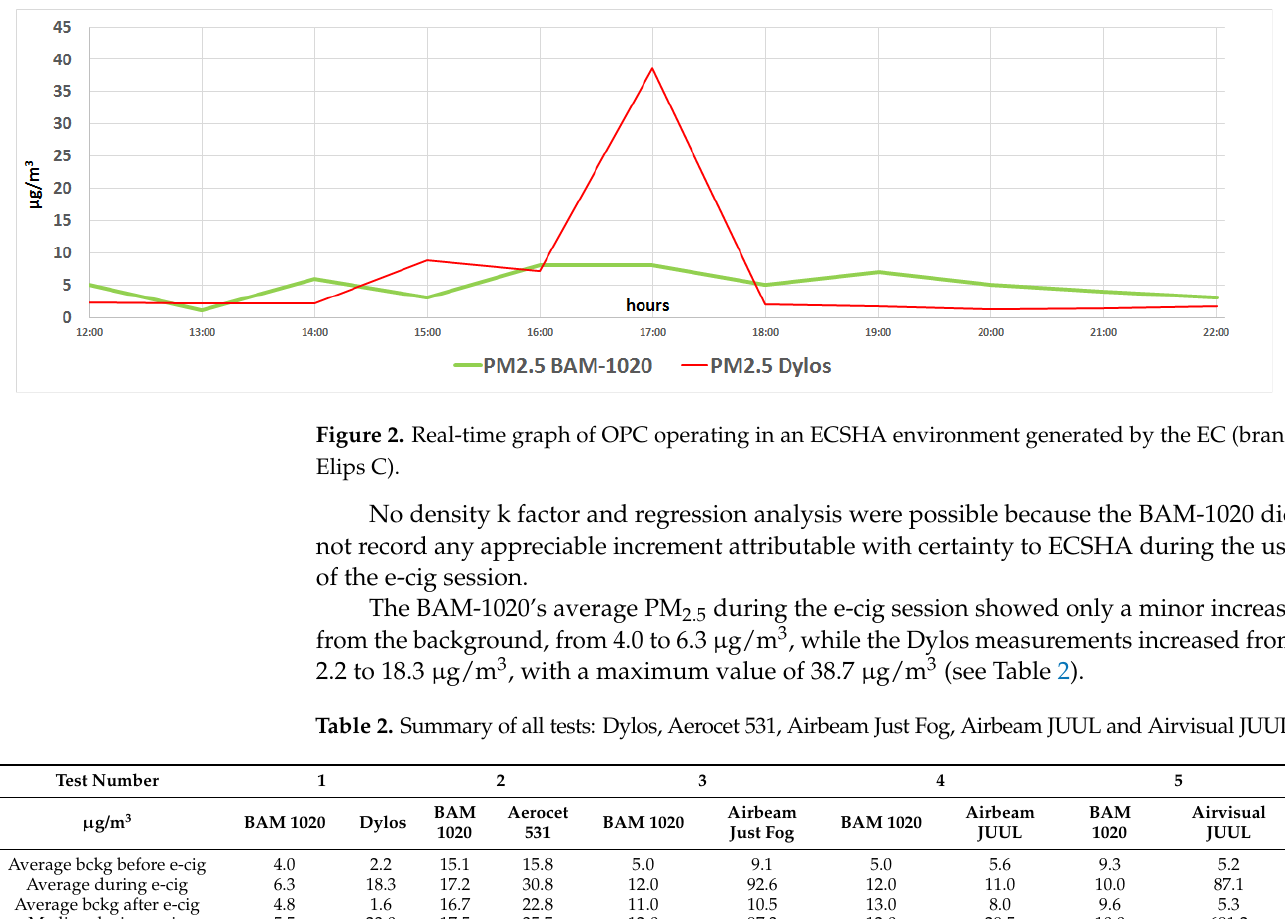
Figure 1. Results of the calibration (in mass of PM 2.5 ) of OPC in SHS from CC: real-time graph ( a ) and linear regression analysis ( b ).